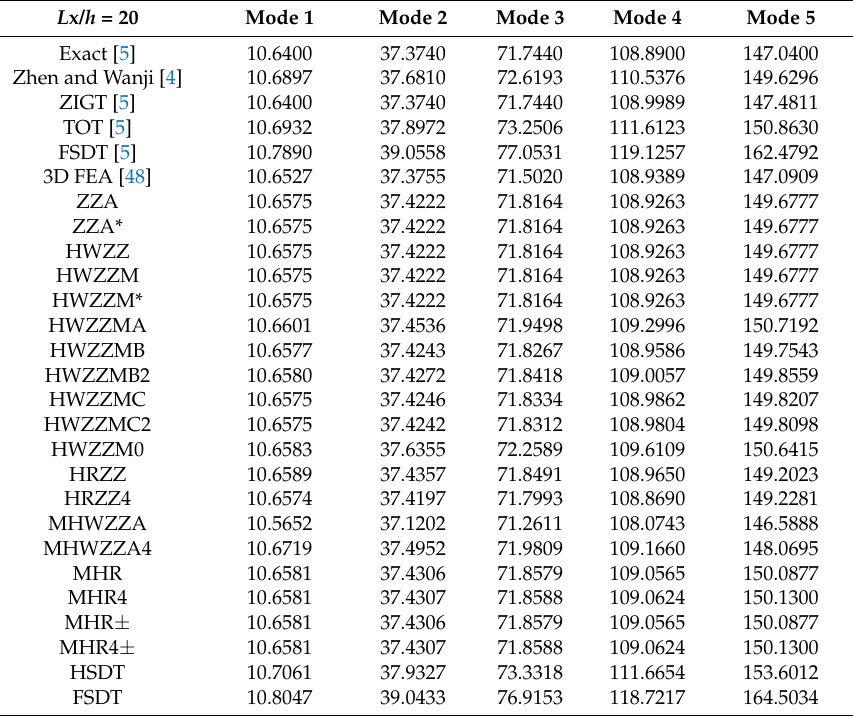
Table 14. Normalized fundamental frequencies, case